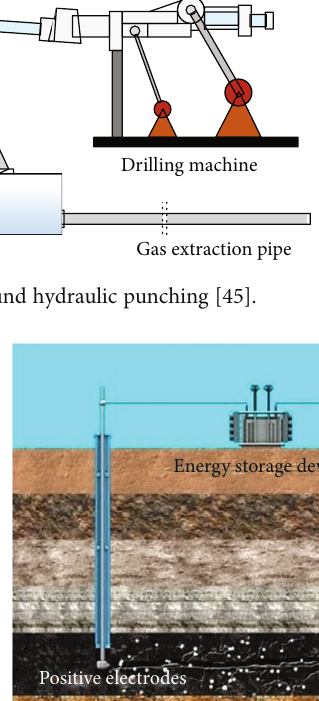
Figure 9: Schematic diagram of coal seam stimulation by using high-voltage electric fracturing